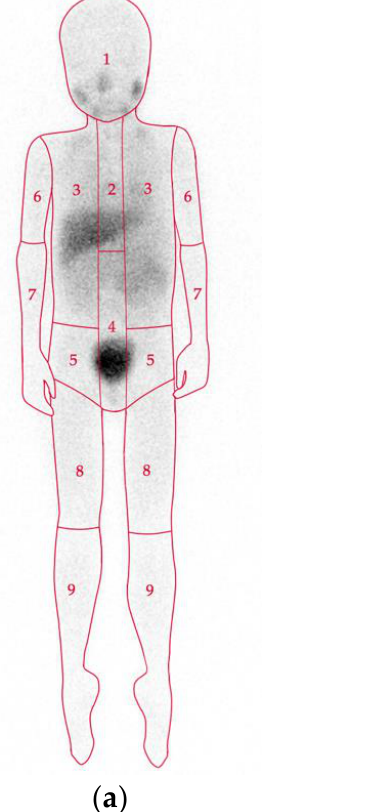
Figure 1. Scoring systems for mIBG scintigraphy. The Curie score ( a ) consists of 9 osteomedullary segments and a 10th soft tissue segment. Each segment is graded as: 0, no involvement; 1, one distinct lesion; 2, two or more distinct lesions; or 3, >50% involvement [27]. The International Society of Pediatric Oncology Europe Neuroblastoma Group (SIOPEN) score ( b ) consists of 12 osteomedullary segments. Each segment is graded as: 0, no involvement; 1, one distinct lesion; 2, two distinct lesions; 3, three distinct lesions; 4, four or more distinct lesions or <50% involvement; 5, >50% involvement; or 6, >95% diffuse involvement [28].